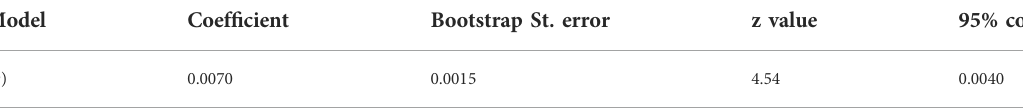
TABLE 8 Signi fi cance test of coef fi cient product β 1 * γ 2 .